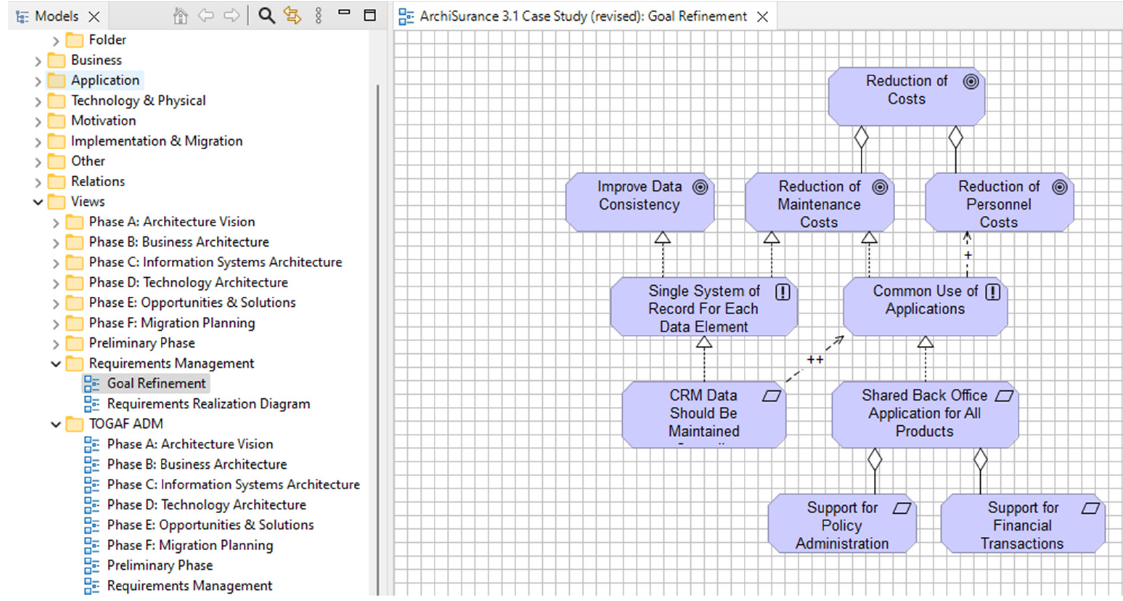
Figure 5. Browsing the use case repository in Archi.